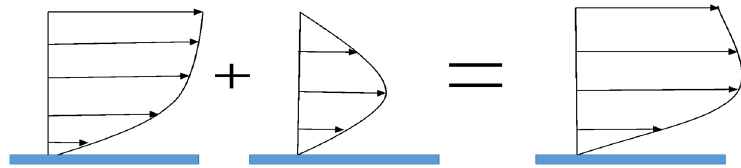
Figure 2. Synthesis of vertical velocity distribution in open-channel bends.